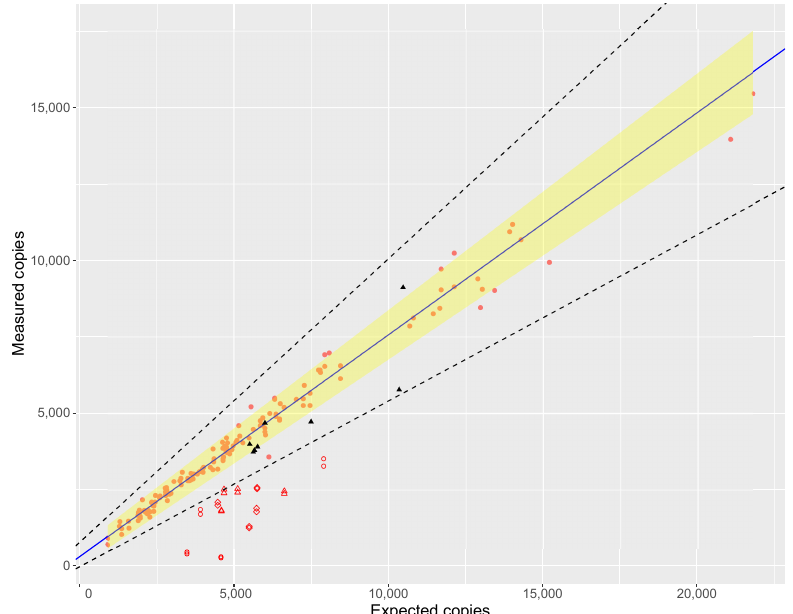
Figure 1. Correlation between measured and expected target copies. The figure shows the Crocus sativus reference samples (•), their correlation line (blue), and 95% prediction interval (shaded area). The boundaries of the acceptable range (80% and 120% ddPCR purity) are shown as dashed lines. Results for the stigma samples are shown in black ( (cid:78) ) and laboratory prepared admixtures are shown in red ( ◦ for samples amdmixed with safflower, (cid:5) for samples admixed with wheat flour, (cid:77) for samples admixed with Capsicum annuum